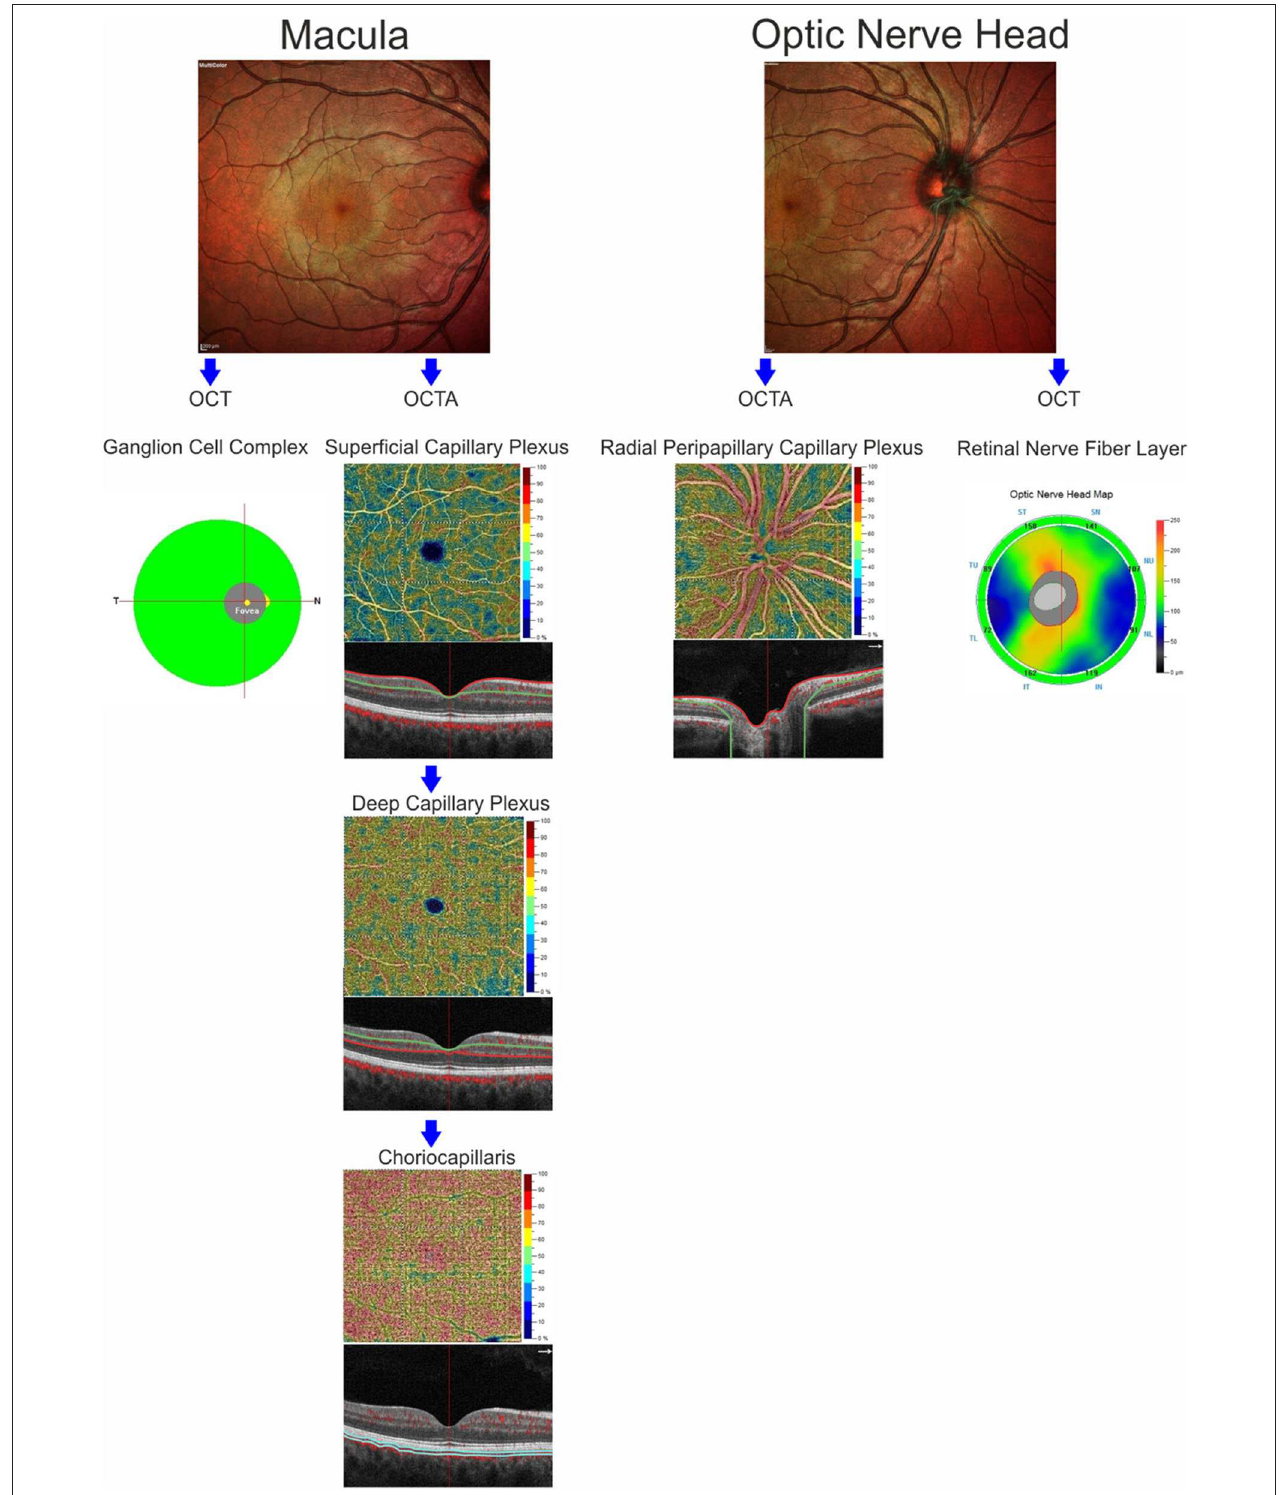
FIGURE 1 | Anatomic illustration of macular and optic nerve head regions showing the retinal structures analyzed by optical coherence tomography (ganglion cell complex and retinal nerve fiber layer) and the retinal and choriocapillaris vascular networks evaluated by OCT-Angiography.